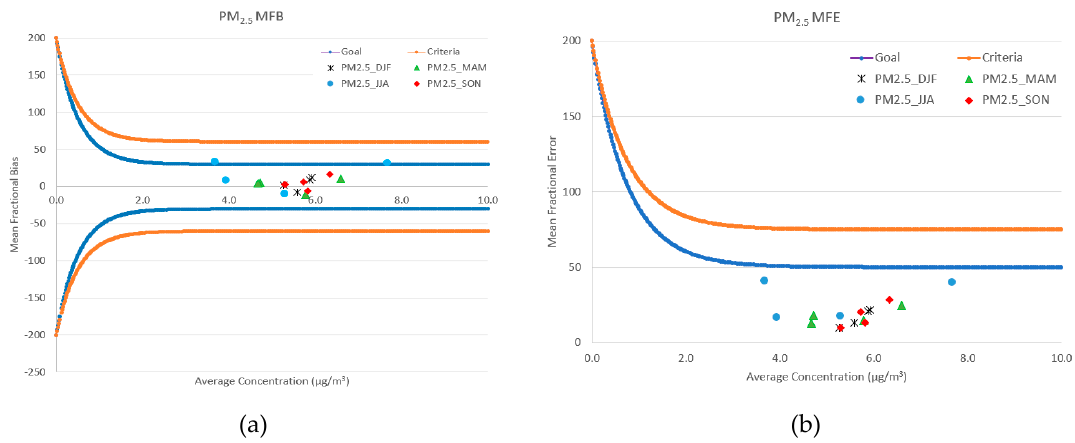
Figure 3. Bugle plots ( a ) mean fractional bias (MFB) and ( b ) mean fractional error (MFE) for PM 2.5 for all predicted/observed pairs values in the Sydney East, Sydney Northwest, Sydney Southwest and Illawarra regions for summer (DJF, black asterisk), autumn (MAM, green triangle), winter (JJA, blue dot) and spring (SON, red diamond). The benchmark criteria (orange lines) and goal (blue lines) for assessing the model performance, as defined by [37], are also shown.